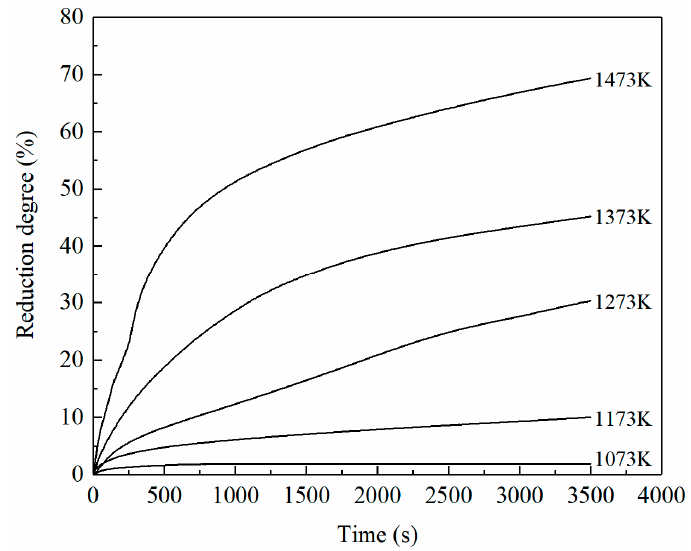
Figure 5. Reduction degree of Y3 (MgO addition) as a function of reaction time.